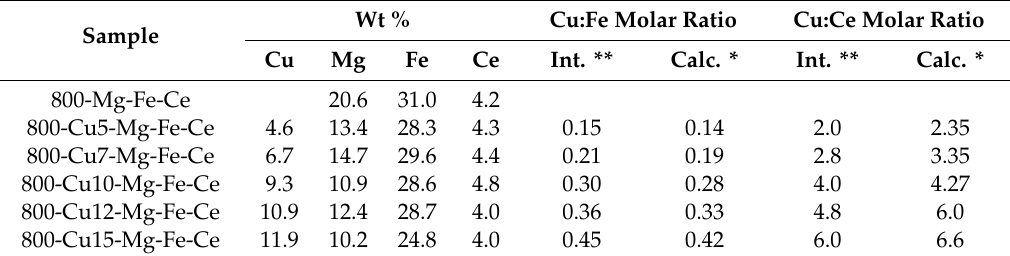
Table 4. Chemical composition of the